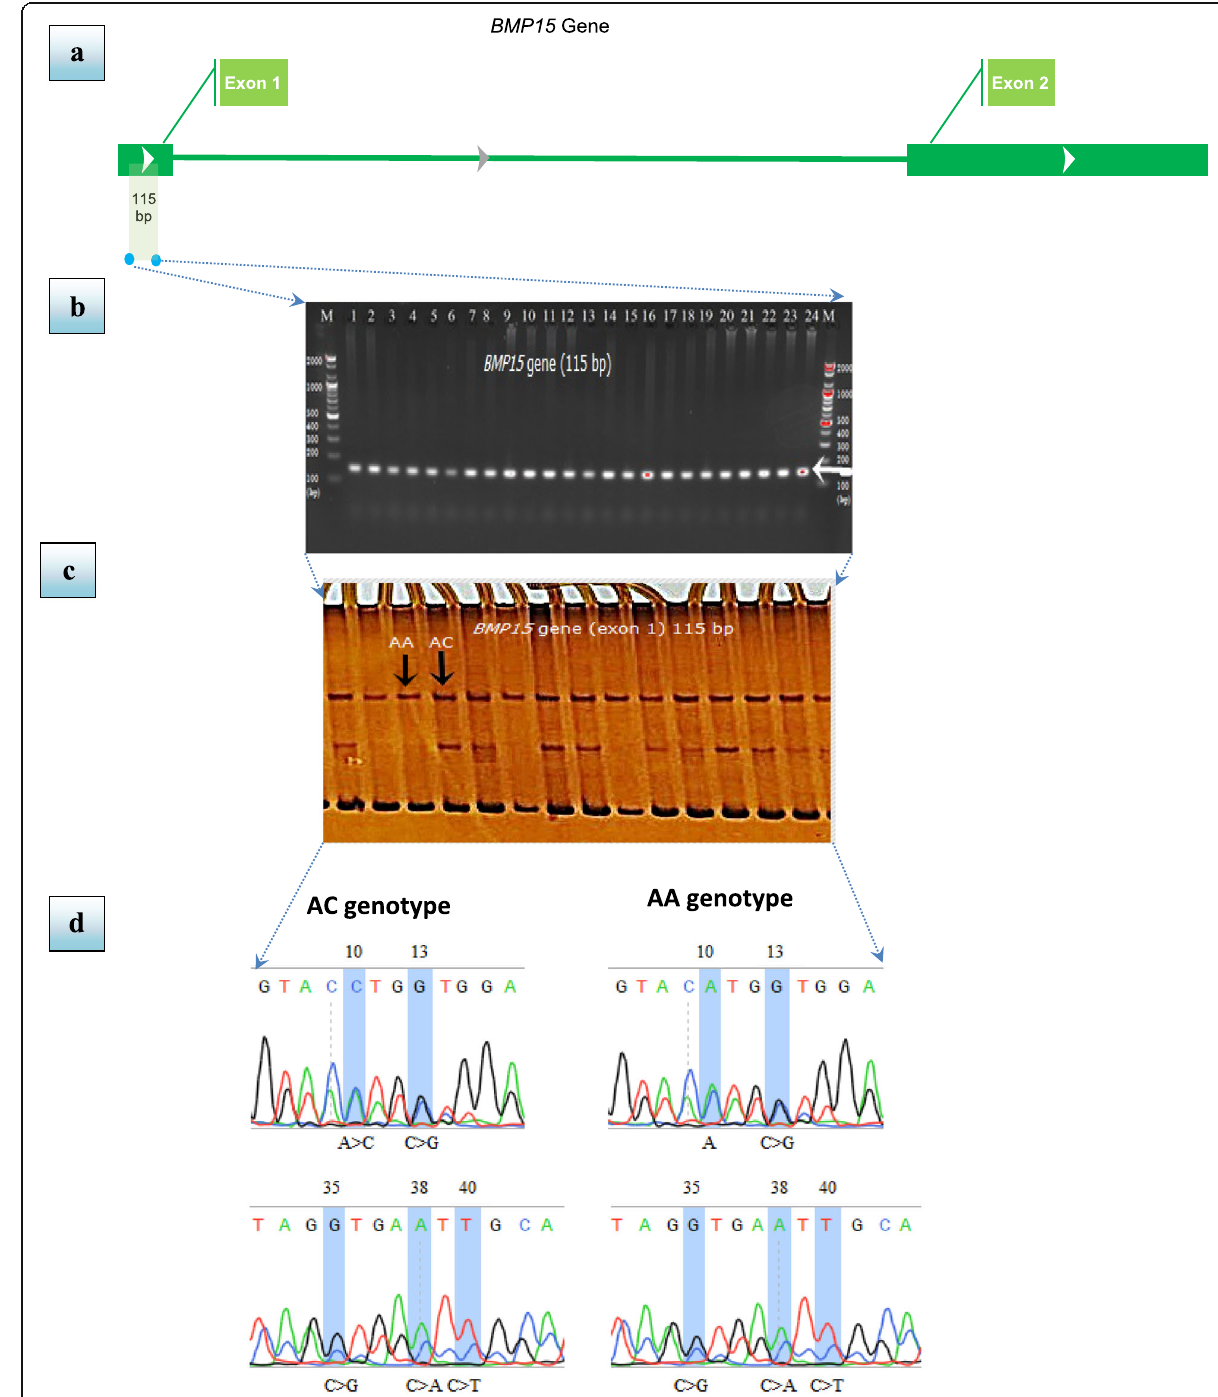
Fig. 2 A schematic diagram of the current study to assess the BMP15 gene polymorphism. a The exact genomic position of the human BMP15 gene was described according to GenBank acc. no. NC_000023.11. b Agarose gel electrophoresis (2%) of polymerase chain reaction (PCR) product of BMP15 gene. c Two SSCP patterns are visible, corresponding to AA and AC genotypes. (d) DNA sequencing alignment results for BMP15 gene two genotypes with their reference sequence (GenBank acc. no. NC_000023.11) using DNA STAR, the Editseq software. Using ClustaW alignment, several point mutations (SNPs) are observed between the BMP15 reference sequence and the two genotypes AA and AC themselves, with one mutation (A/C) observed in AC genotype at locus 10 substitute than the AA